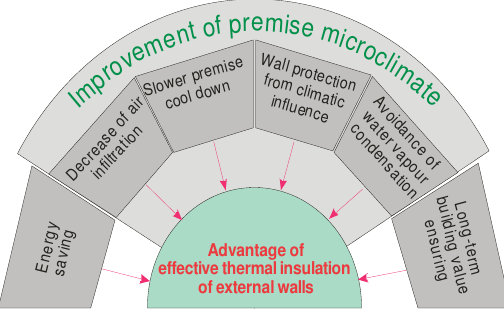
Fig. 2. Advantage of effective thermal insulation of external walls